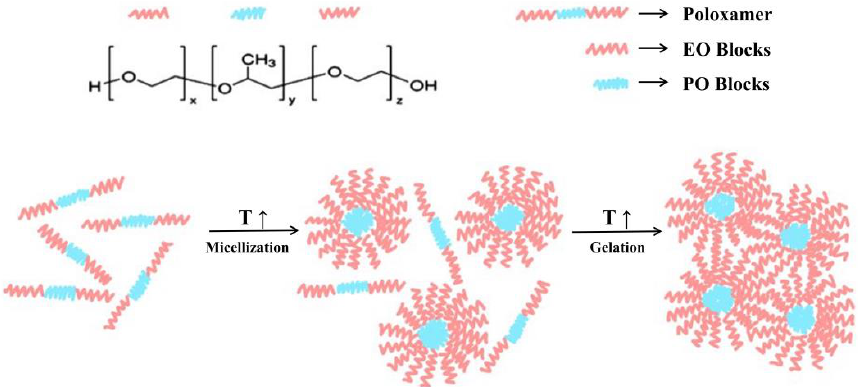
Figure 4. Poloxamer gelation process. The image has been taken from the publication by Zarrintaj et al. [7] with permission.